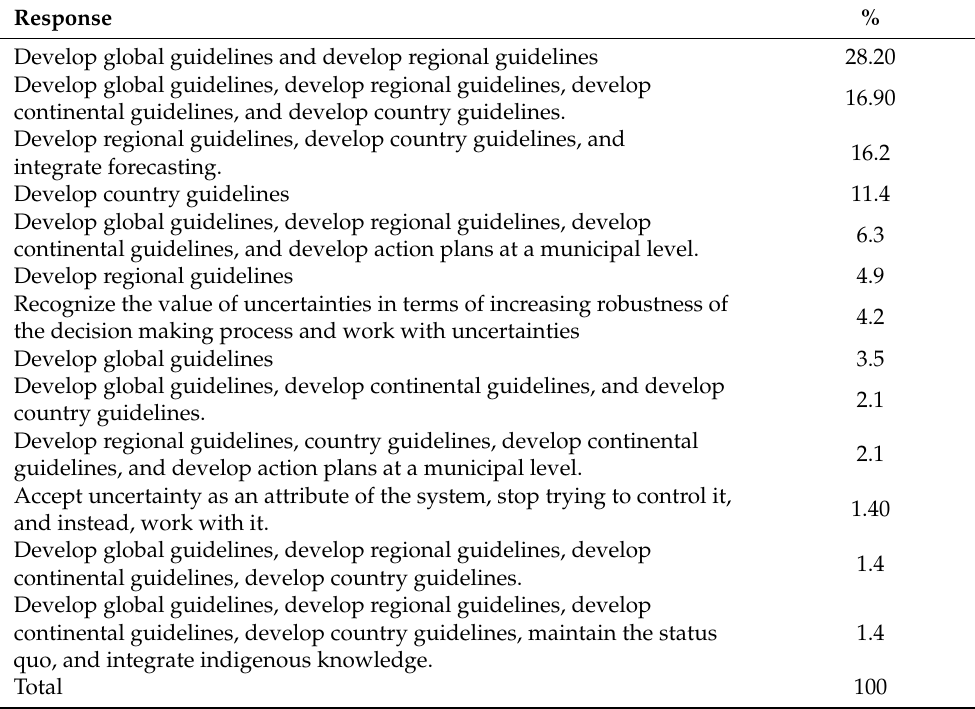
Table 6. Percentage responses on ways to reduce uncertainties in climate change and adaptation.